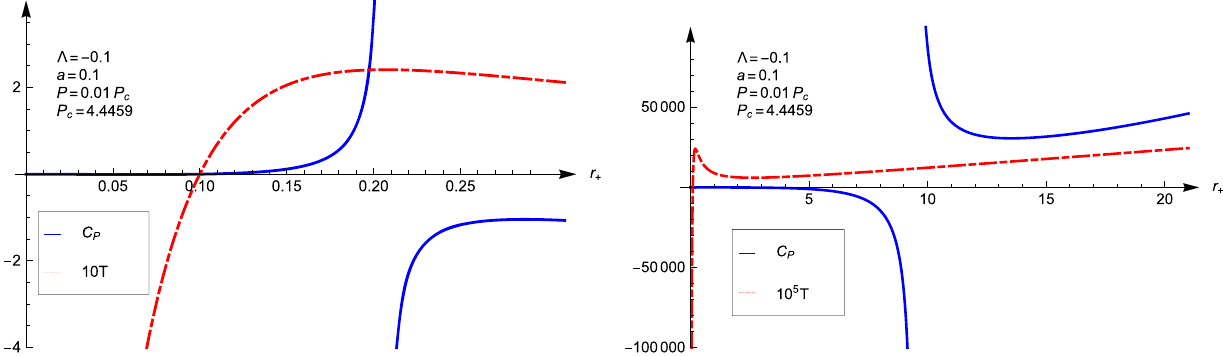
Fig. 6 Heat capacity versus r + for (cid:2) = − 0 . 1, a = 0 . 1 and P = 0 . 01 P c , which shows divergencies in two different regions. The dashed line corresponds to 10 T (right panel) and 10 5 T (left panel)